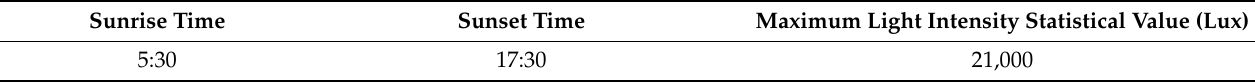
Table A11. Parameters of the interday light components in Scenario III in the case